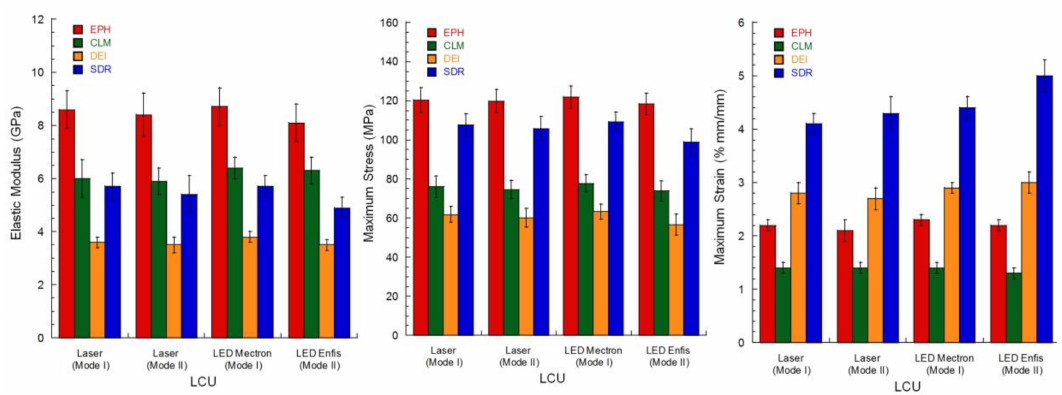
Figure 8. Mechanical properties of restorative composites after 7 days since curing, according to light source and curing mode. The results are reported in terms of mean values, the bar represents the standard